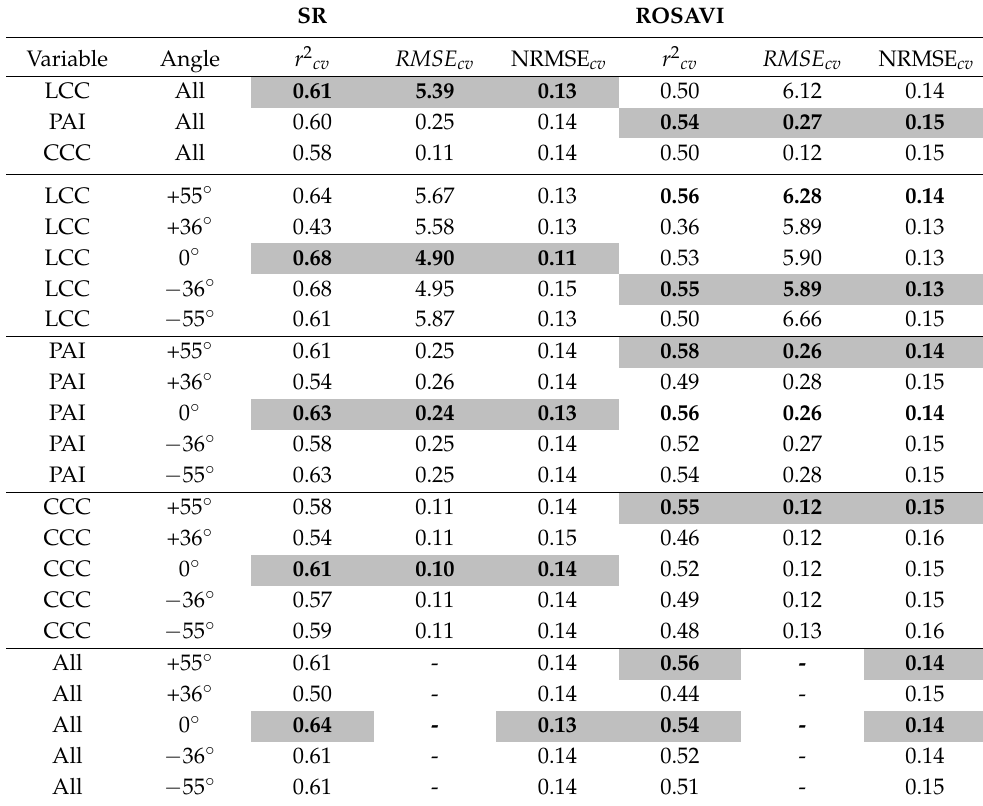
Table 2. Global simple ratio (SR) and revised optimized soil adjusted vegetation index (ROSAVI) model performance for combined field sites. Root mean squared error (RMSE) units: leaf chlorophyll content, LCC ( µ g/cm 2 ); plant area index, PAI (m 2 /m 2 ); canopy chlorophyll content, CCC (g/m 2 ). Normalized root mean squared error (NRMSE) = RMSE/range of measured data. The best